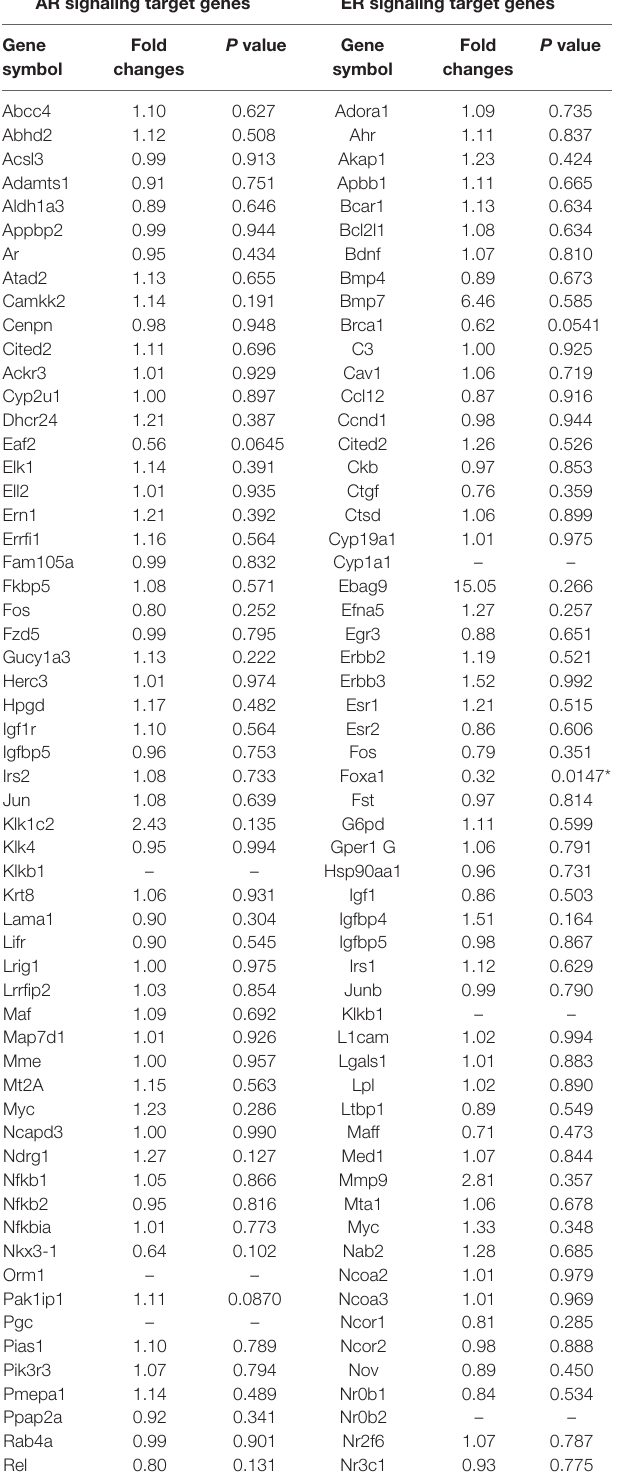
Table 1 | Effect of Bisphenol A (BPA) on androgen receptor (AR) and estrogen receptor (ER) signaling target gene expression in the medial amygdala of neonatal male